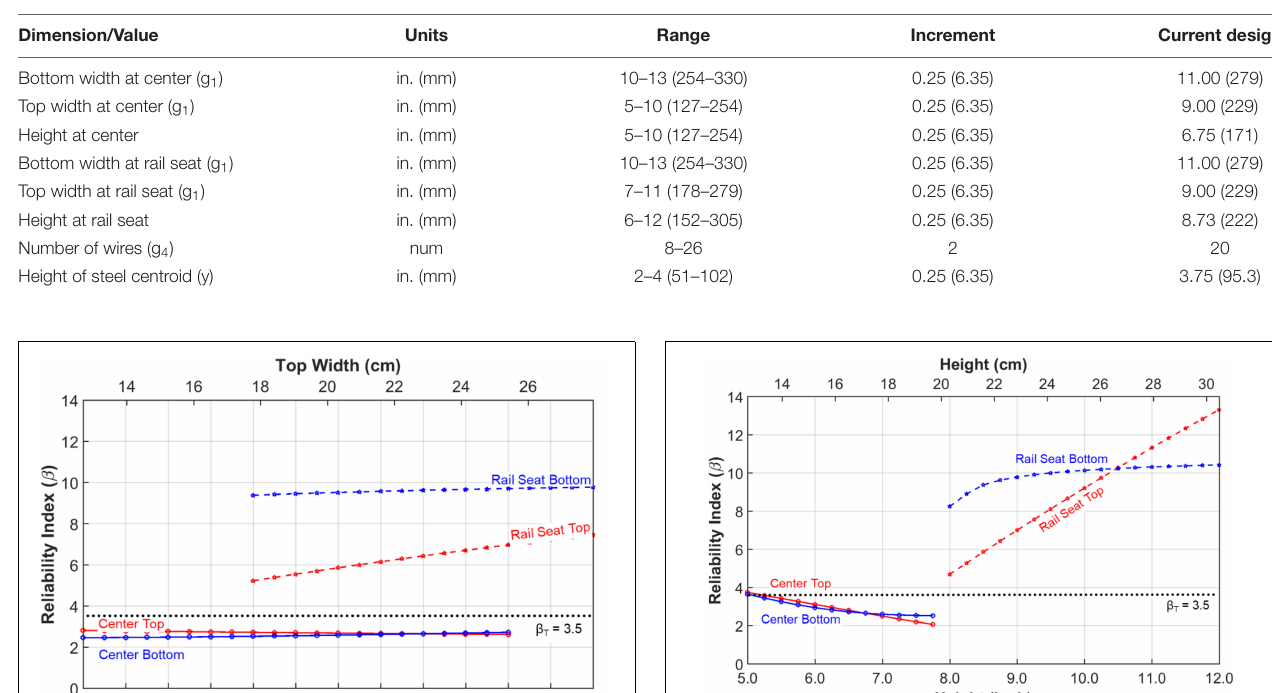
TABLE 5 | Bounds for sleeper design deterministic input parameters.